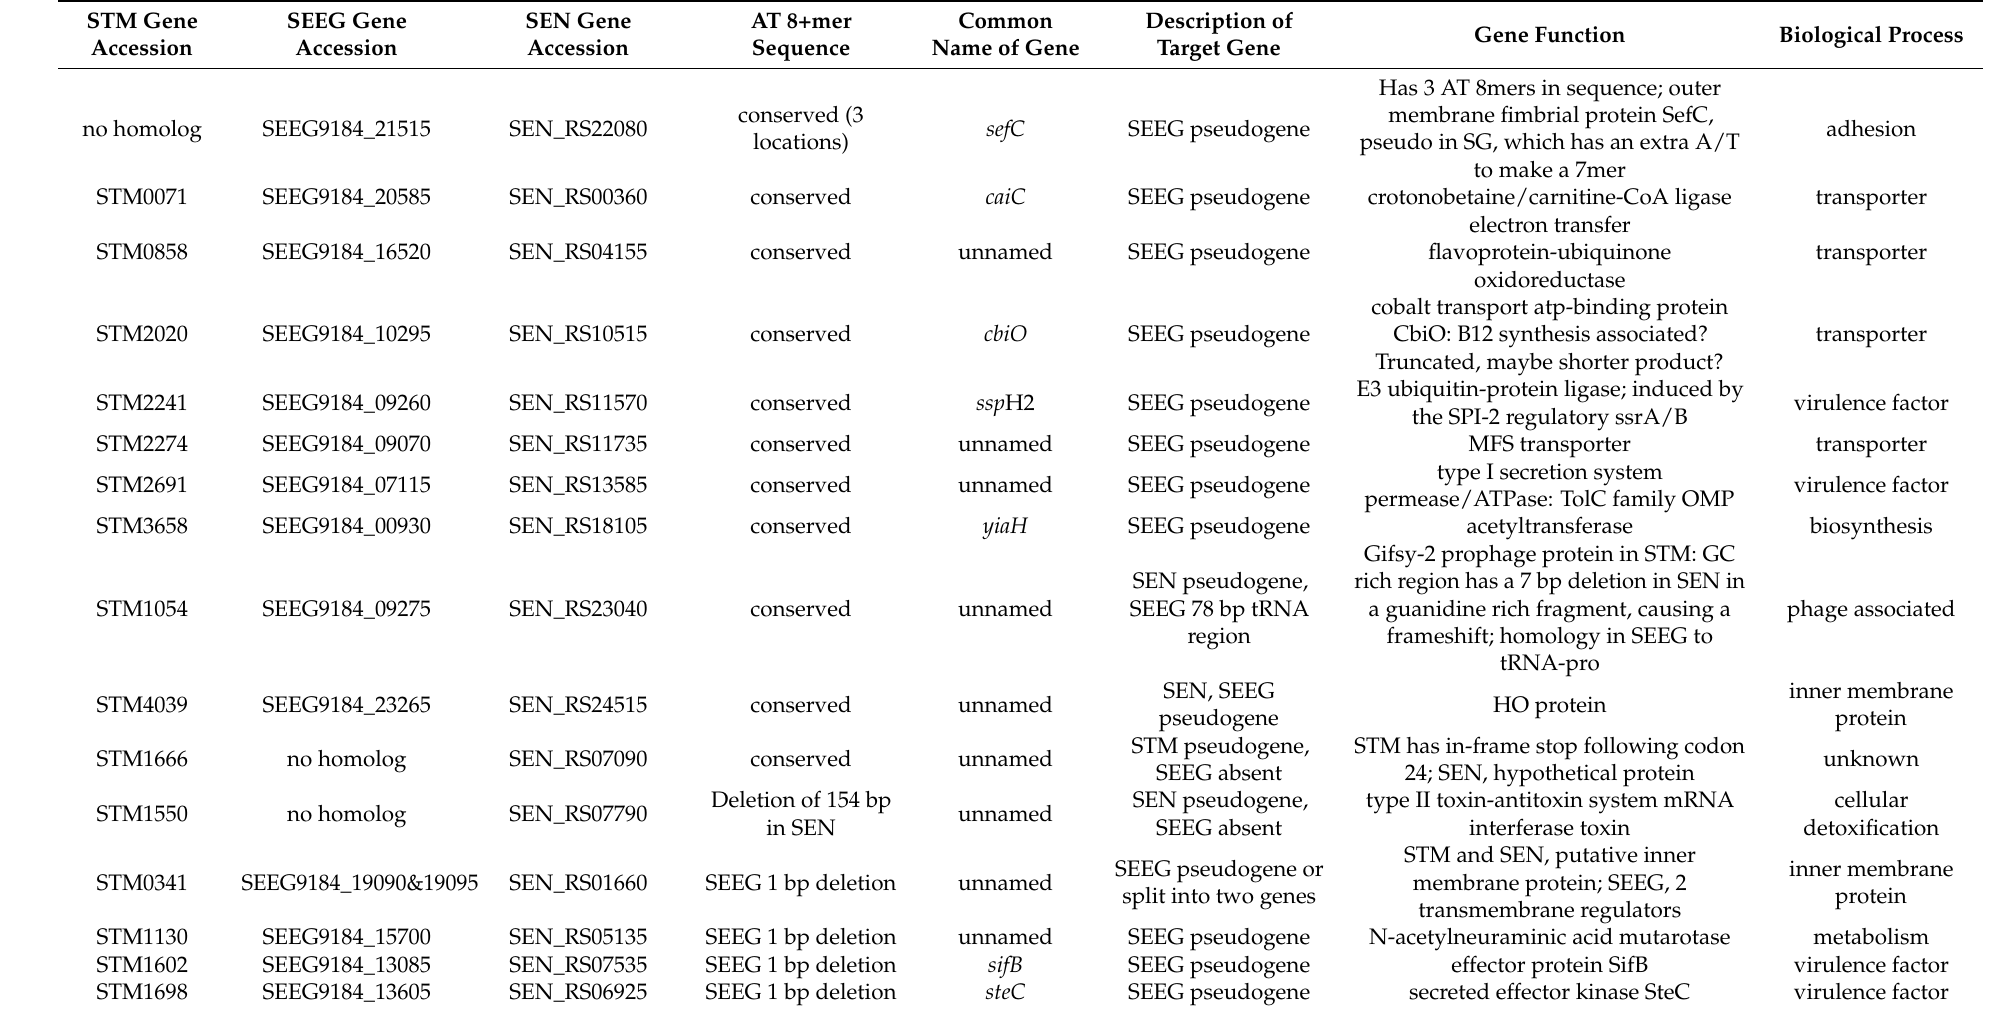
Table 2. AT 8+mer motifs associated with gene disruption or altered regulatory regions in S. enterica serovars Enteritidis, Table